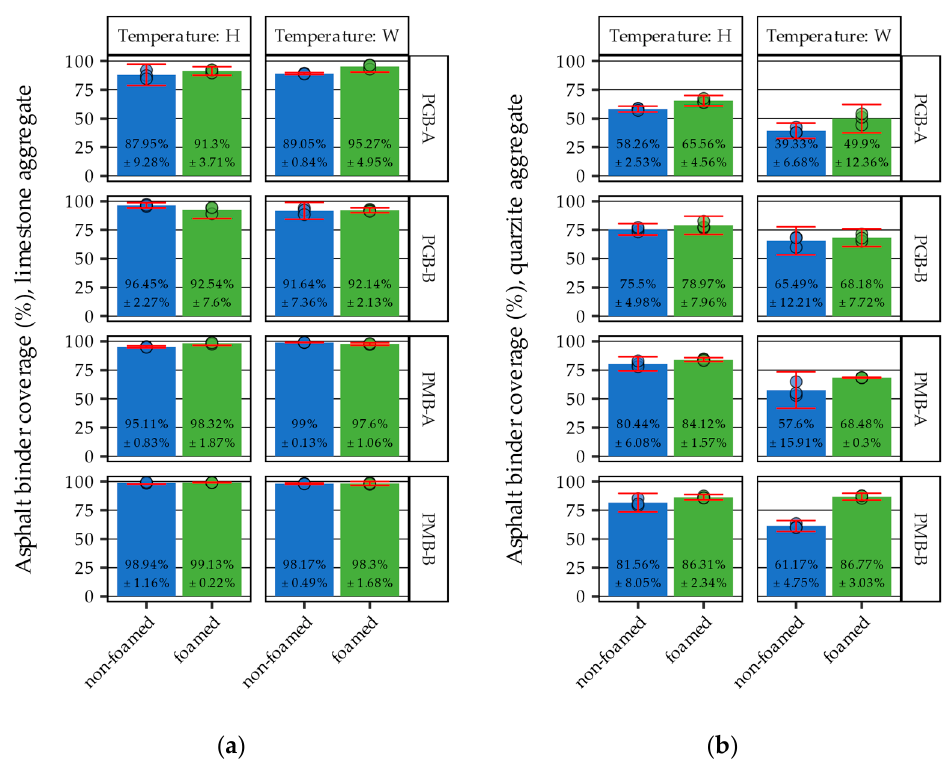
Figure 10. Results of boiling water stripping tests: ( a ) limestone aggregate; ( b ) quartzite aggregate.